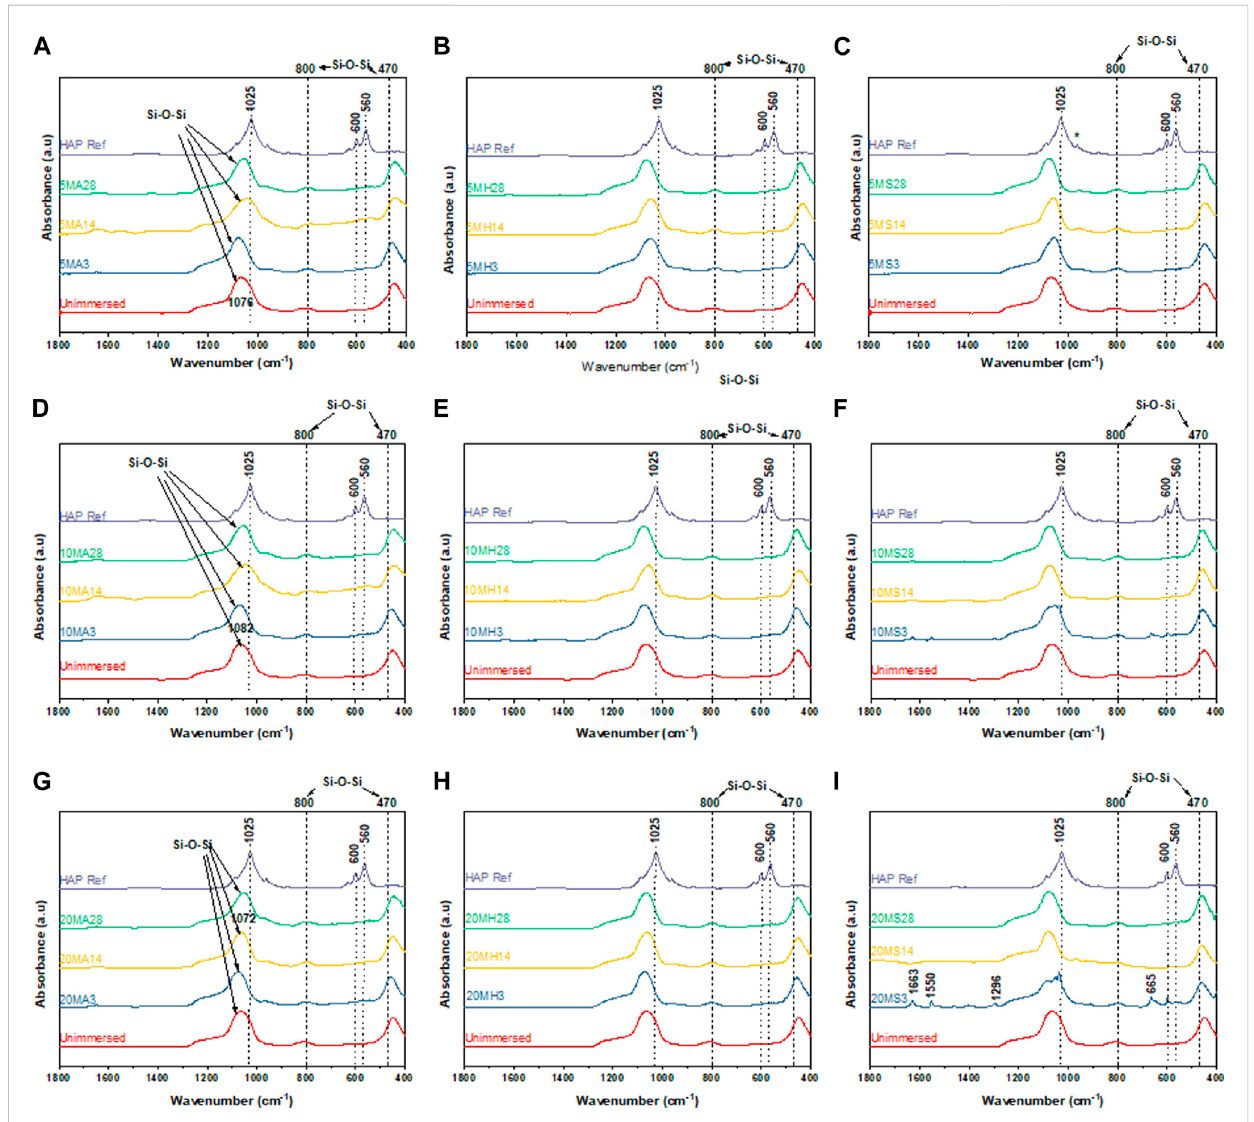
FIGURE 10 FTIR spectra for the doped glasses after immersion in the three media for 3 days, 14 days and 28 d 5LiMBGNs in AS (A) , HBSS (B) and SBF (C) ; 10LiMBGNs in AS (D) , HBSS (E) and SBF (F) ; and 20LiMBGN sin AS (G) , HBSS (H) and SBF (I) .